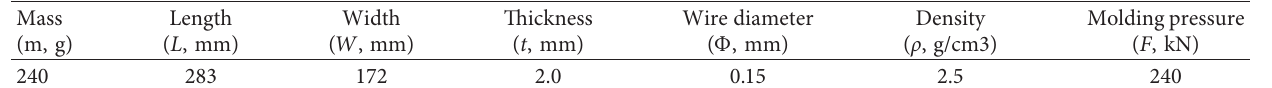
Table 1: Preparation parameters of metal rubber.